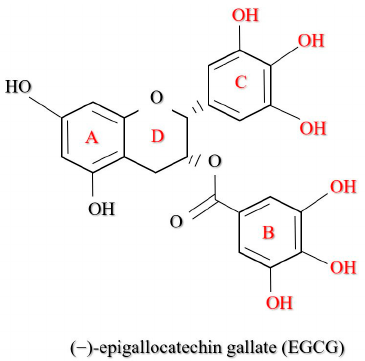
Figure 5. The EGCG comprises four rings designated as A, B, C, and D. The A and C rings form a benzopyran ring system, which relates to the pyrogallol (the B ring) and gallate (the D ring) moiety at the C-2 and C-3 positions, respectively. The role of the functional groups in the antioxidant properties of EGCG was described based on other studies.